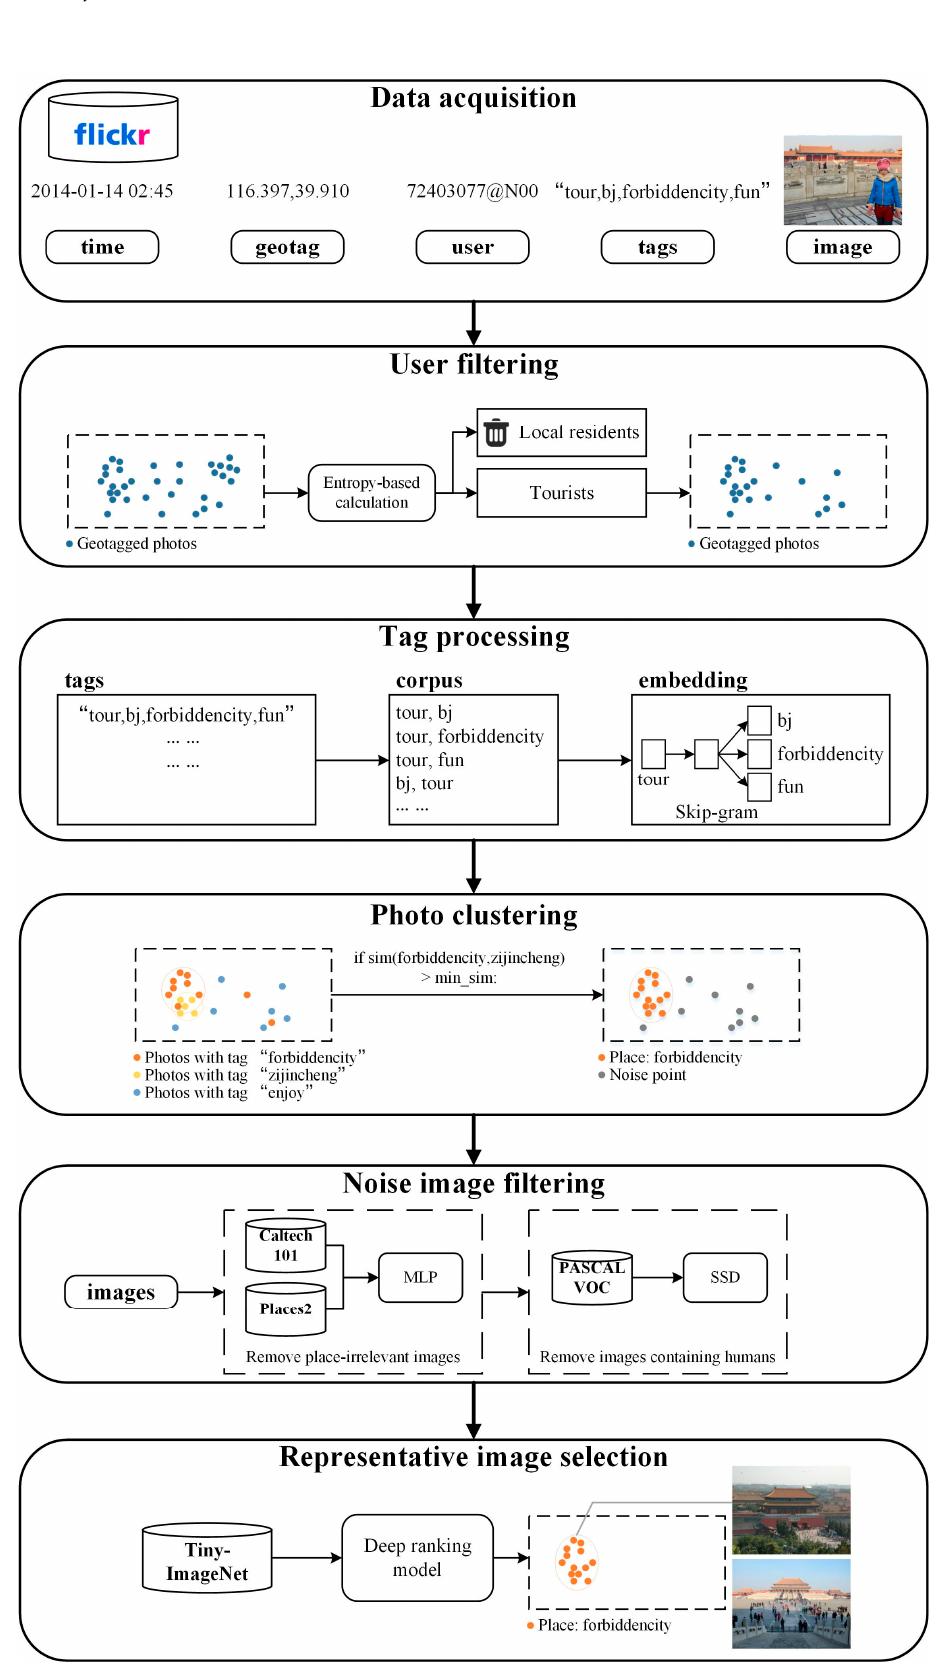
Figure 1. The framework of representative image extraction of tourist attractions from Flickr (These photos in Figure 1 are all licensed by: http://creativecommons.org/licenses/by-nc-sa/2.0/).